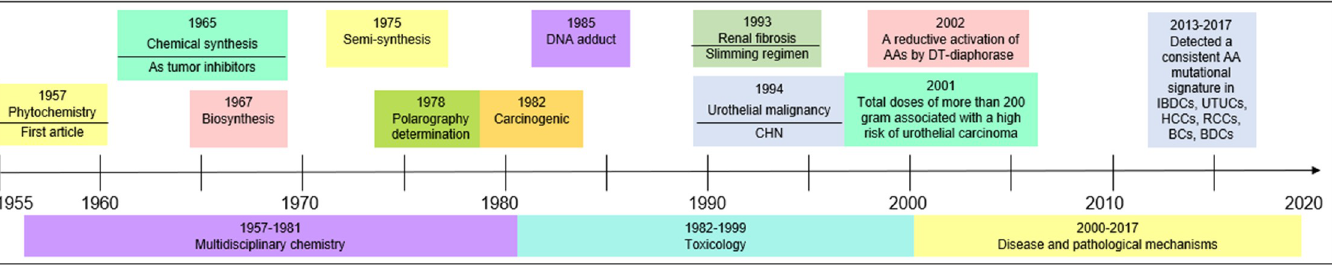
PLOS ONE | https://doi.org/10.1371/journal.pone.0216135 May 2,